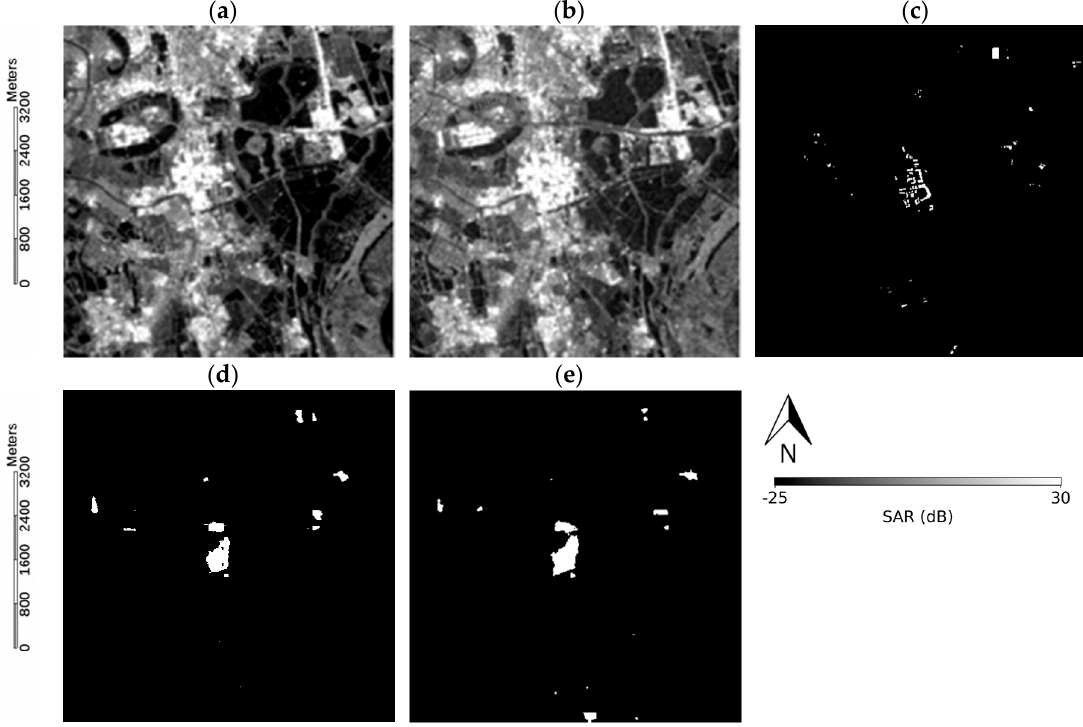
Figure 11. Result of the Hanoi site at 20 ° 57 ′ 06.35”N 105 ° 51 ′ 08.87”E. The size of each image is 6 × 6 km. ( a ) Time 1 SAR data; ( b ) Time 2 SAR data; ( c ) ground truth; ( d ) result of proposed model; ( e ) result of U-net.